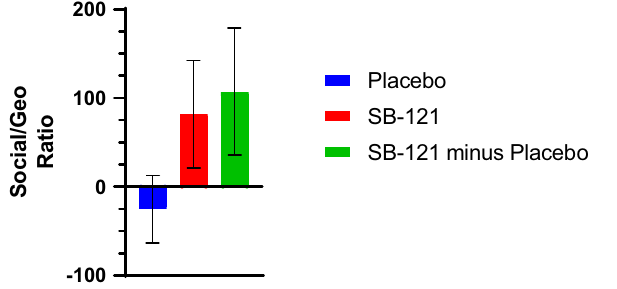
Figure 4. Eye tracking change from baseline score—social/geometric ratio (LS means, SEM).